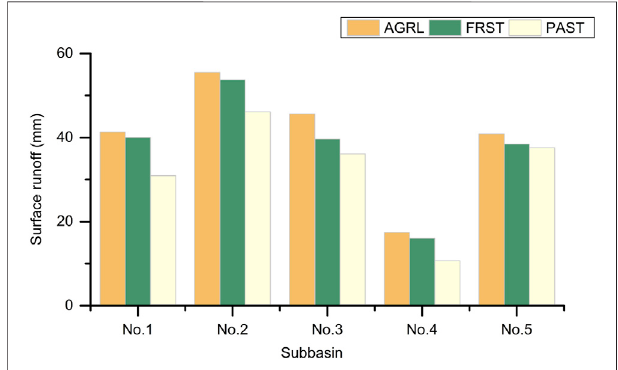
FIGURE9| Averageannualsurfacerunoffdepthineachsubbasinunder different land use types.